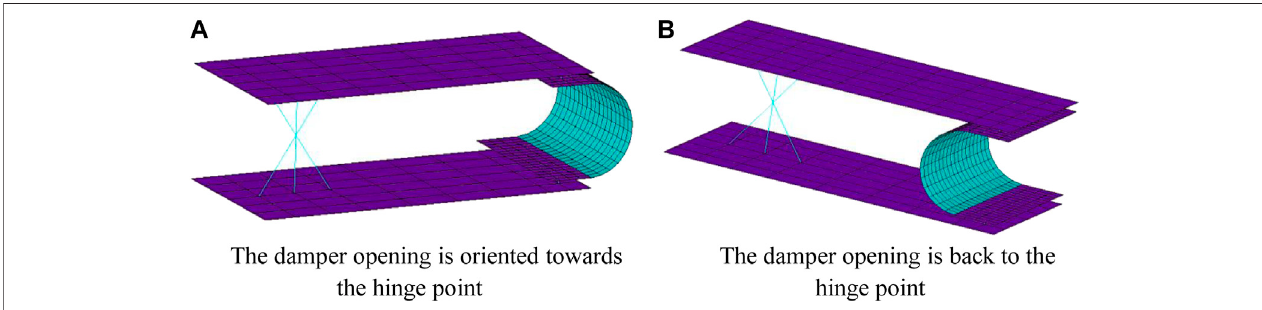
FIGURE 9 | Finite element model. (A) The damper opening is oriented towards the hinge point. (B) The damper opening is back to the hinge point.